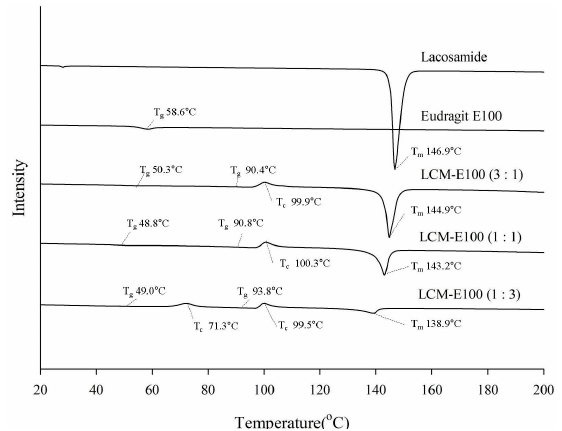
Figure 3. DSC thermograms of lacosamide, Eudragit E100, LCM-E100 (3:1), LCM-E100 (1:1) and LCM-E100 (1:3).